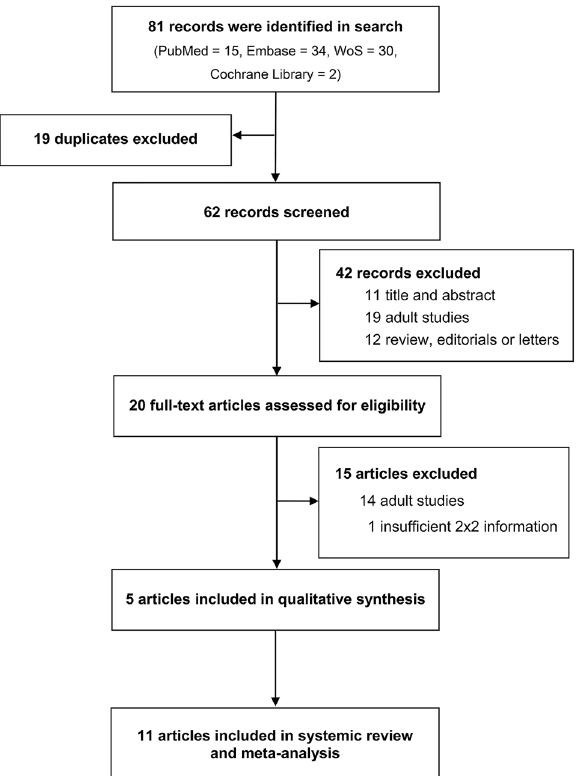
Figure 1. Flow diagram of the search and selection